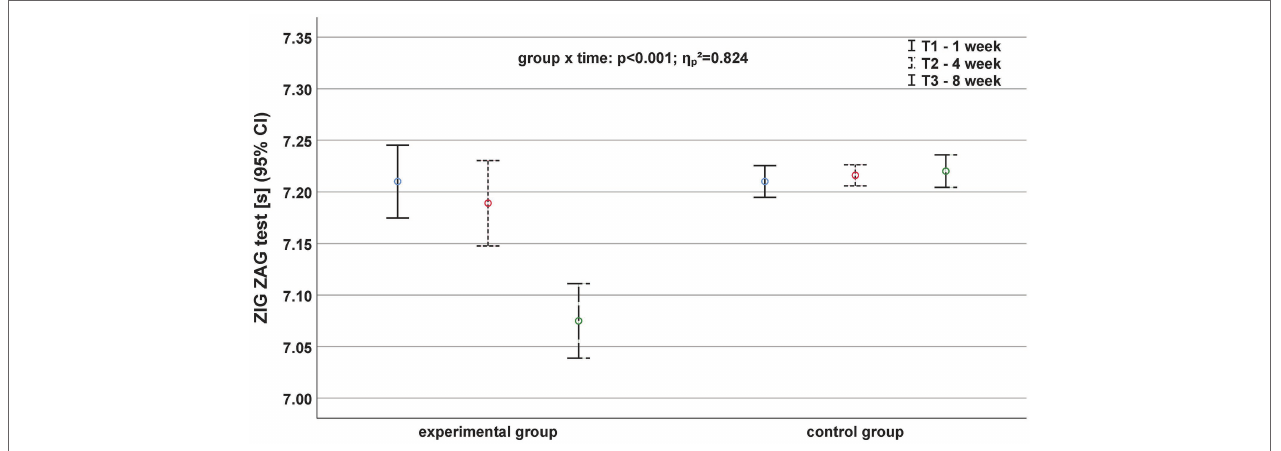
FIGURE 4 | Development of agility performance based on the parameter ZIG-ZAG test before (continuous black line), after 4 weeks (fine dashed black line), and after (roughly dashed black line) the exercise program depending on the